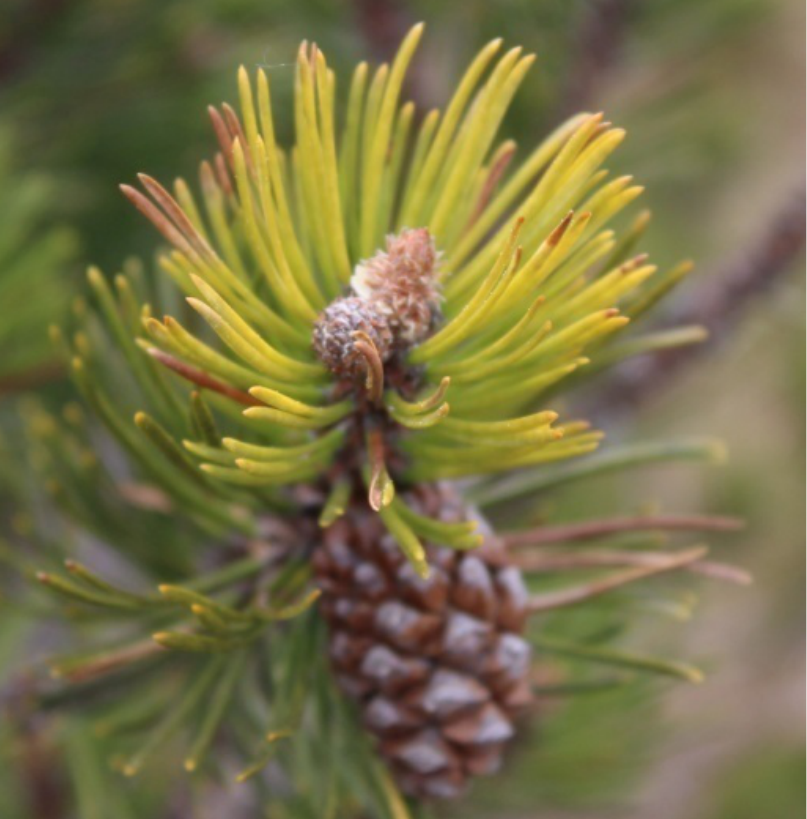
Figure A1. Yellow needles of a bog pine growing in the centre of the ‘Hinterzartener Moor’ in April 2014.